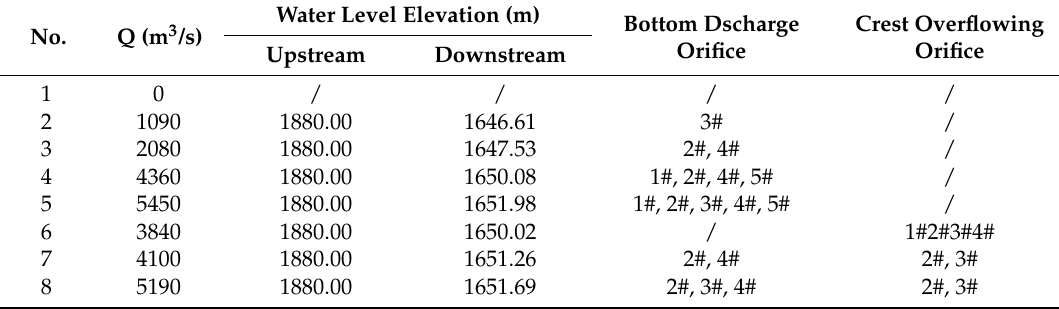
Table 1. Observed discharge conditions